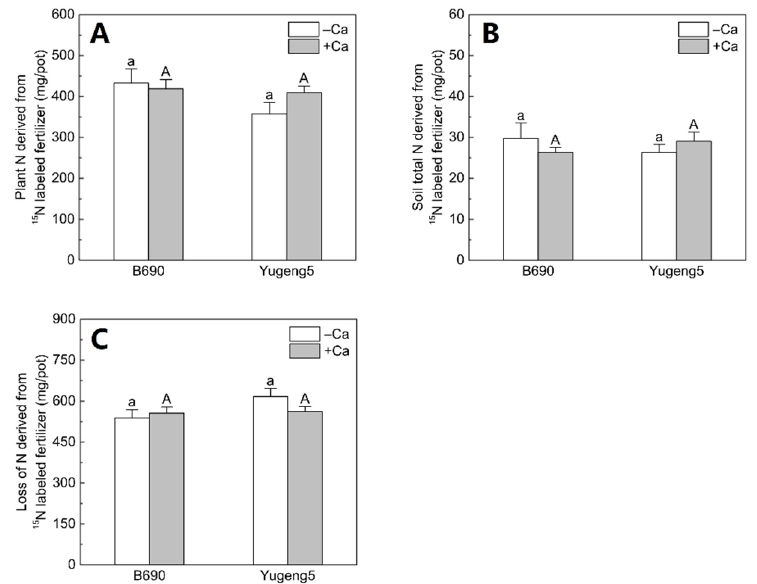
Figure 6. Pathway of 15 N-labeled fertilizer nitrogen (N) in plant – soil systems after the harvesting of two rice cultivars ‘B690 ′ and ‘Yugeng5 ′ . Two rice cultivars were grown in pots in a greenhouse without ( − N) or with (+N) N fertilizer, in the absence ( − Ca) or presence (+Ca) of lime, till maturity. ( A ), Plant N derived from 15 N-labeled fertilizer; ( B ), soil total N derived from 15 N-labeled fertilizer; ( C ), loss of N derived from 15 N-labeled fertilizer. Loss of fertilizer was calculated as the difference between amount of applied fertilizer N and the sum of fertilizer N recovered in plant and soil. Different lowercase and capital letters above bars indicate significant differences between the two rice cultivars under – Ca and +Ca conditions, respectively ( p < 0.05, independent-sample t test). Independent-sample t test showed no significant difference between − Ca and +Ca treatments for the two rice cultivars at 5% level.